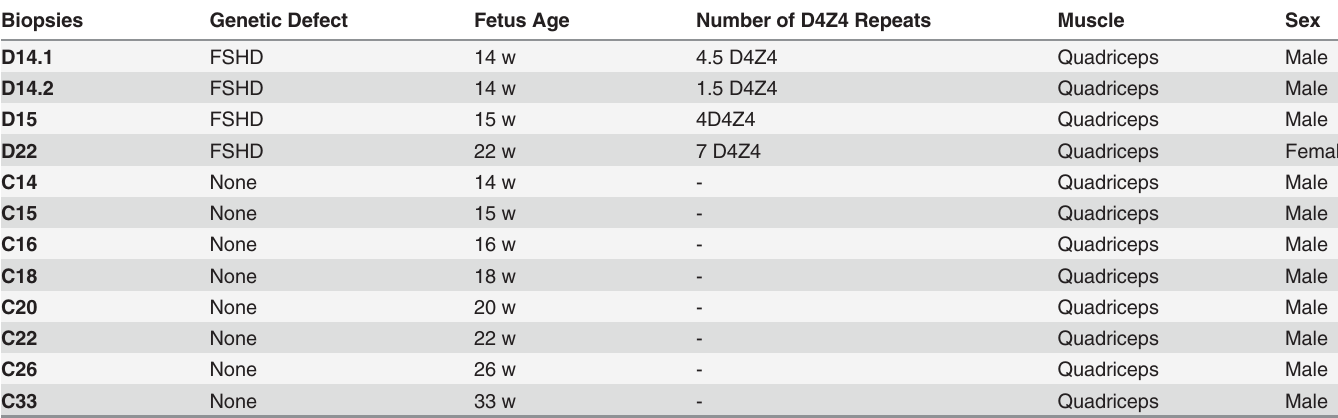
Table 1. Features of the analyzed